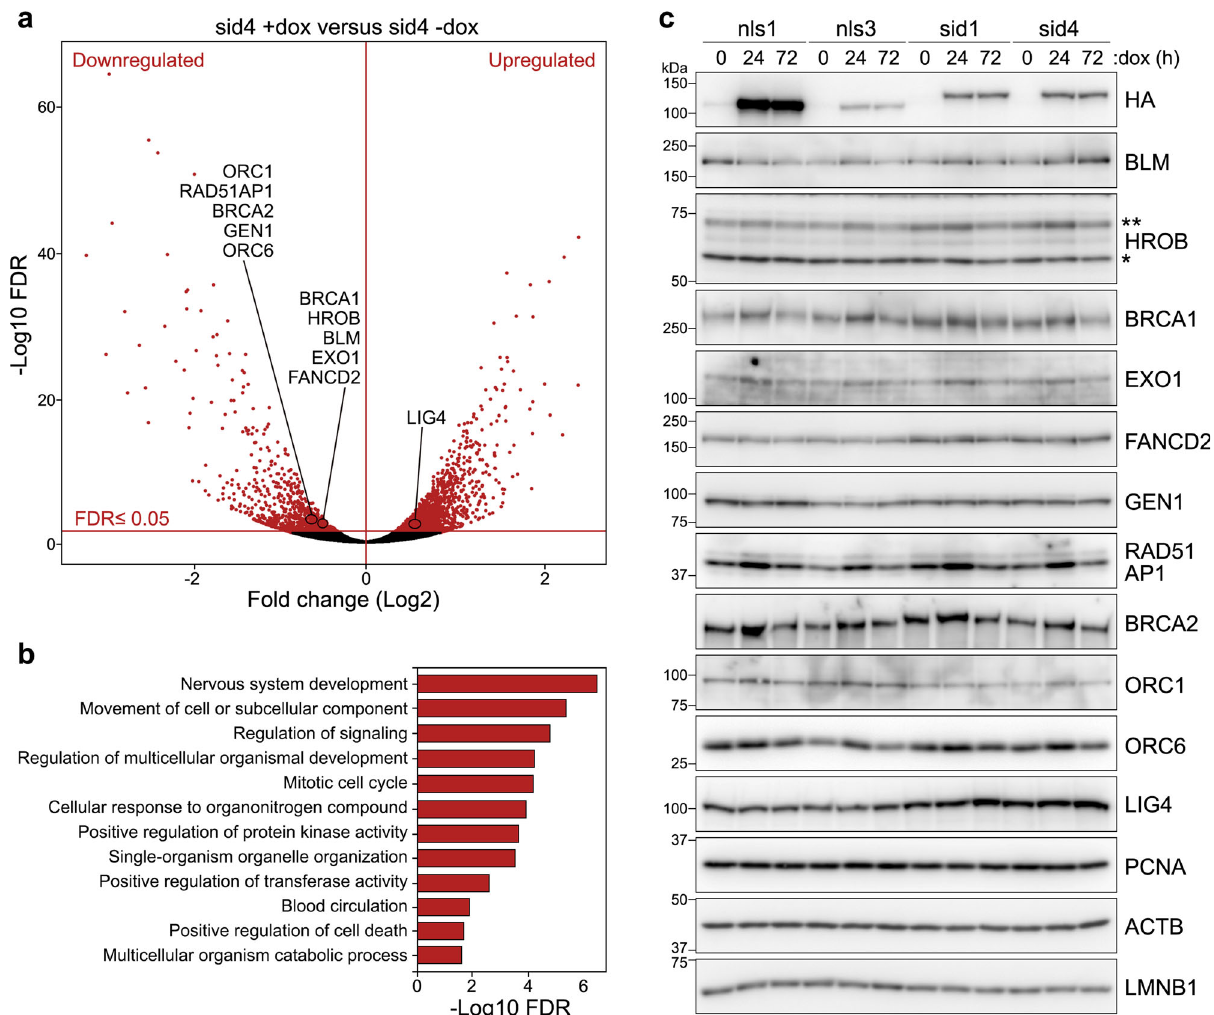
Fig. 6 TERRA transcription inhibition leads to transcriptomic changes. a Volcano plot of RNA-seq transcriptome data displaying the pattern of gene expression values in the comparison of sid4 cells treated with dox for 72 h versus untreated sid4 cells. Signi fi cantly differentially expressed genes ( P ≤ 0.05 of Benjamini – Hochberg correction of nominal P -values obtained from the applied two-sided Wald test) are in red. Genes involved in DNA metabolism are indicated. b Bar plot representation of the Gene Ontology analysis of differentially expressed genes identifying signi fi cantly enriched biological process functional categories (FDR P ≤ 0.05). Statistical signi fi cance for each term is indicated on the X axis by the − log10 of the FDR P -value. c Western blot analysis of DNA metabolism factors identi fi ed in a . The indicated cell lines were treated with dox for 24 or 72 h or left untreated. Images are from different identical membranes. PCNA, Beta Actin (ACTB) and Lamin B1 (LMNB1) serve as loading controls. For HROB, the two asterisks indicate variants 1 and 4, the single asterisk variant 3. Images are representative of experiments repeated at least twice. Source data are provided as a Source Data fi